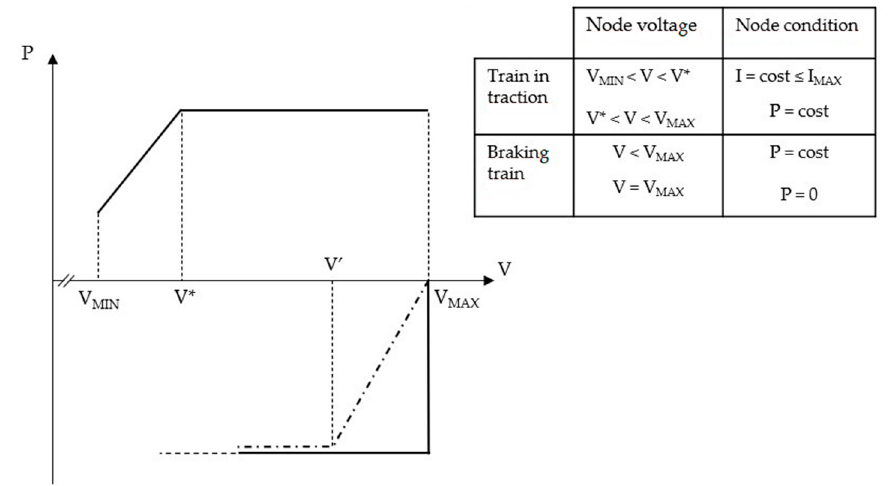
Figure 3. V-P characteristic of traction vehicles.